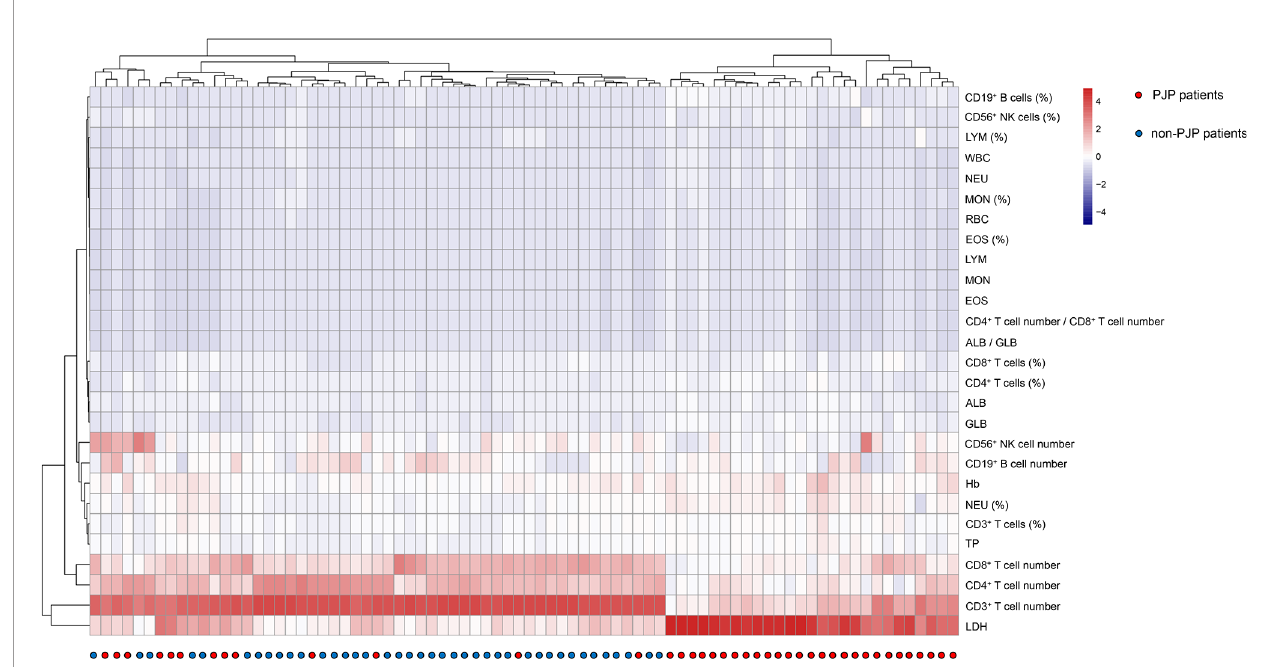
FIGURE 2 | Clustering analysis of routine laboratory and immunological indicators in PJP and non-PJP patients. On the y axis are indicator values after z-scoring, and on the x axis are individual patients. Red-white-blue squares represent z-scoring values. WBC, white blood cells; NEU, neutrophils; LYM, lymphocytes; MON, monocytes; EOS, eosinophils; RBC, red blood cells; Hb, hemoglobin; TP, total protein; ALB, albumin; GLB, globulin; LDH, lactate